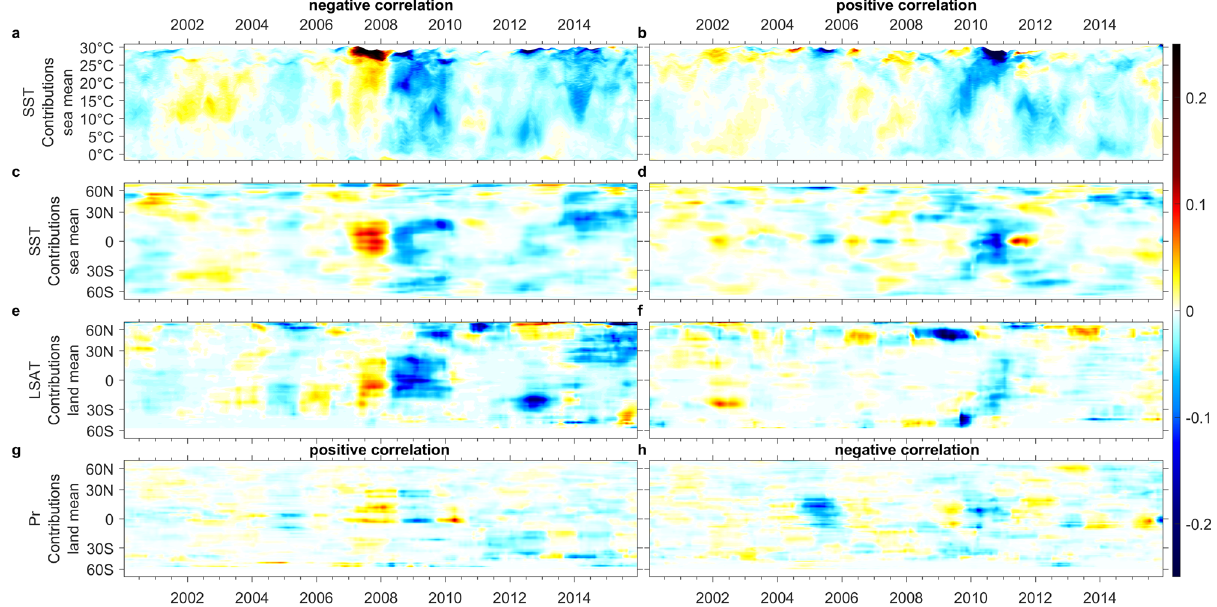
Fig. 3 Breakdown of estimated exclusive SST , LSAT , and Pr contributions to d ( δ 13 CH 4 ) /dt ( ‰ yr − 1 ) with a negative and positive sign of n IF a (or correlation). c – h Lat x time coordinate) and a , b SST x time coordinate. A negative ∂ ( δ 13 CH 4 ( T )) / ∂ t could be a result of rising temperature with negative n IF a,T (i.e., positive feedback) or decreasing temperature with positive nIF a,T (i.e., negative feedback). Similarly, a positive ∂ ( δ 13 CH 4 ( Pr )) / ∂ t could be due to decreasing precipitation with negative n IF a,Pr or increasing precipitation with positive n IF a,Pr .